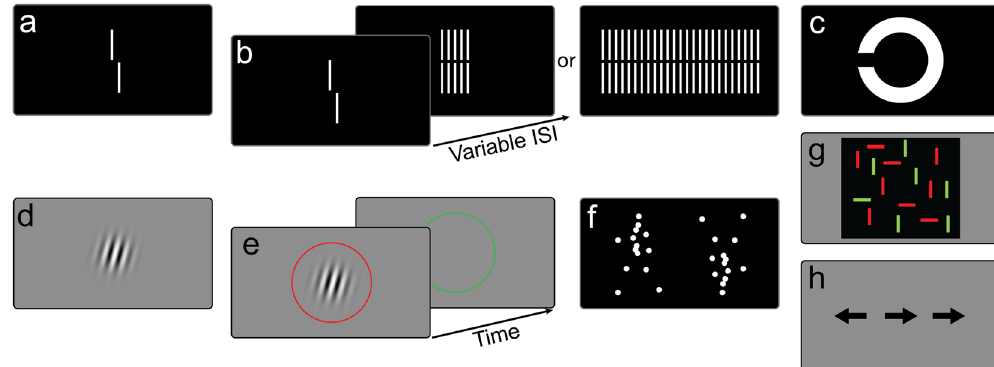
Figure 1. Perceptual tasks: ( a ) vernier duration; ( b ) visual backward masking; ( c ) Freiburg visual acuity test; ( d ) orientation discrimination; ( e ) contrast detection threshold; ( f ) biological motion upright and inverted; ( g ) visual search, ( h ) Simon